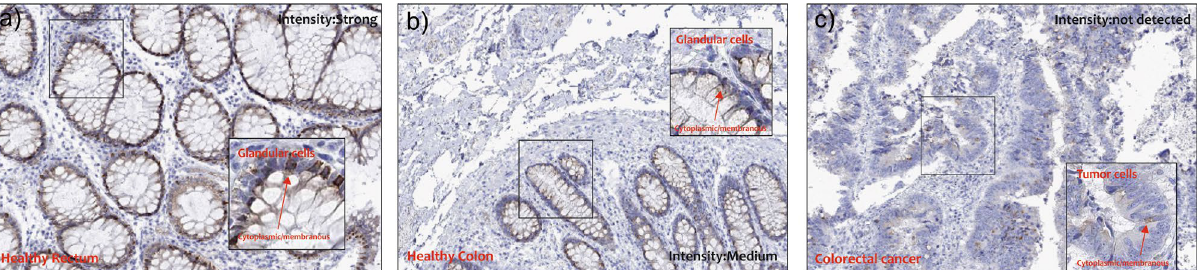
Figure 6. RETNLB protein detection in healthy rectum/colon and in CRC biopsies from the human atlas protein. Immunostaining for RELMB in rectum ( a ), colon ( b ), and CRC ( c ). The boxes represent magnification of the original figure. The red arrows indicate the location. The images downloaded from the Human Atlas Project (https:// www. prote inatl as. org/) have been re-adapted using CorelDraw. The original files web site links are available as well as the complete analyzes, in Supplementary Table 1.